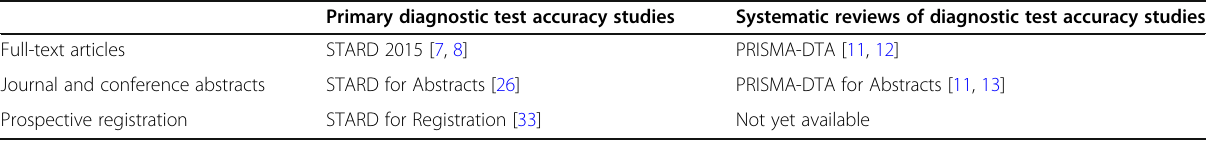
Table 2 Available reporting guidelines for diagnostic test accuracy